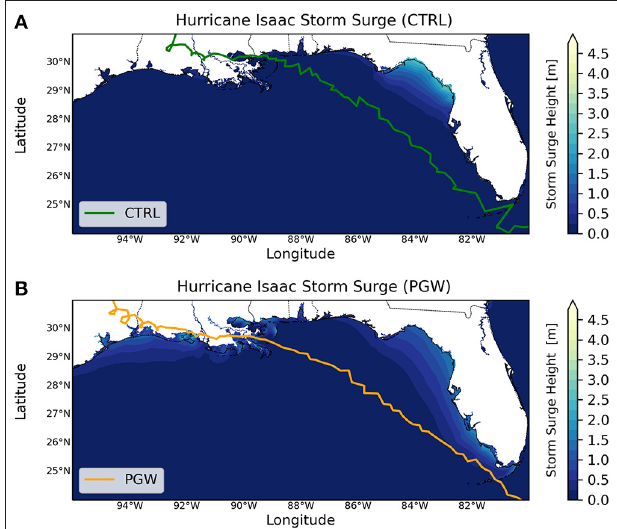
TABLE 2 | Total inundation extent (wetted area) computed for each hurricane and corresponding changes over the 21st century. FIGURE 7 | (A) Maximum storm surge levels of the Hurricane Isacc PGW Area (km 2 ) simulation. Storm surges are lower, but affect portions of Louisiana and southwest Florida. (B) Maximum storm surge levels of the Hurricane Isaac CTRL simulation. Portions of northwest Florida are inundated with storm surges over 2m.